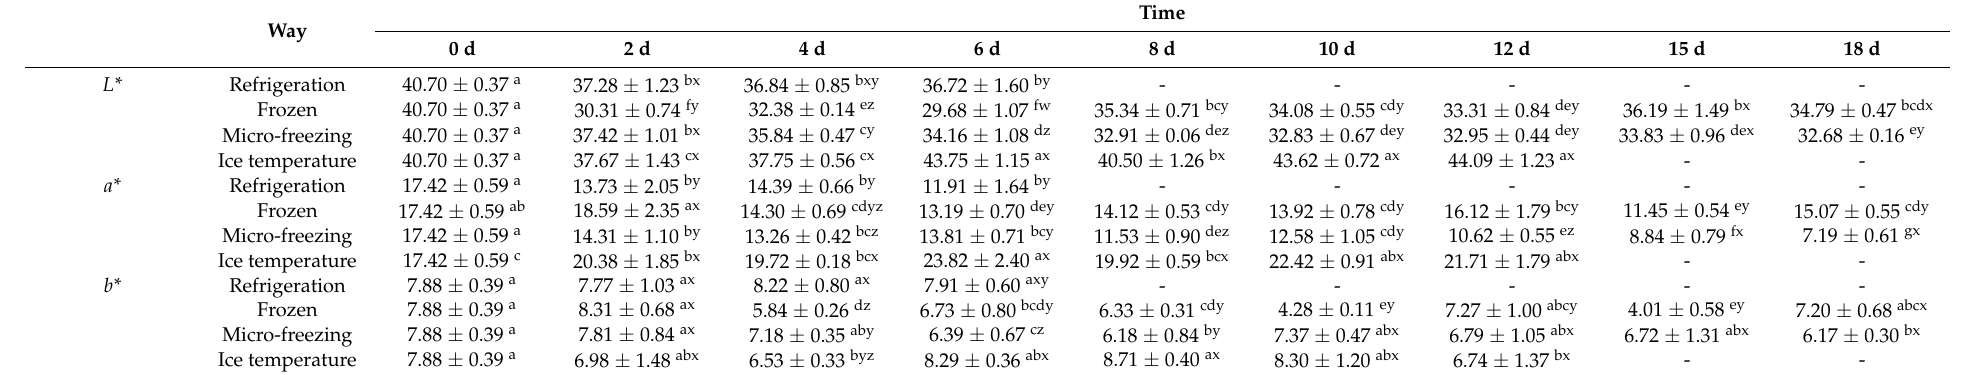
Table 1. Changes in the color difference value of beef with different low-temperature storage